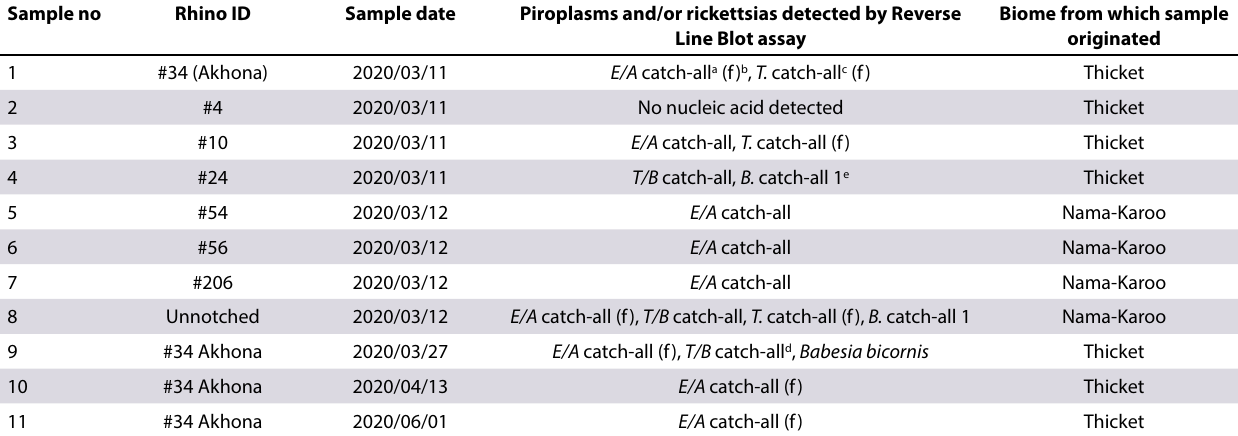
Table II: Piroplasms ( Babesia spp. and Theileria spp.) and blood-associated rickettsias ( Ehrlichia spp. and Anaplasma spp.) detected by Reverse Line Blot assay in blood samples from eight black rhinoceroses captured (11 and 12 March 2020) in the Thicket or Nama-Karoo biomes in Addo Elephant National Park (AENP) and subsequent sampling while in holding facilities at AENP Sample